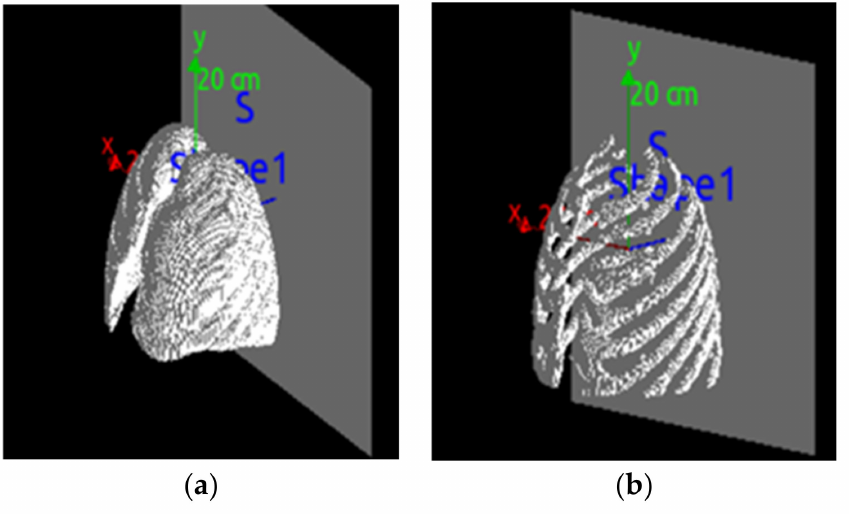
Figure 5. Lung ( a ) and rib cage ( b